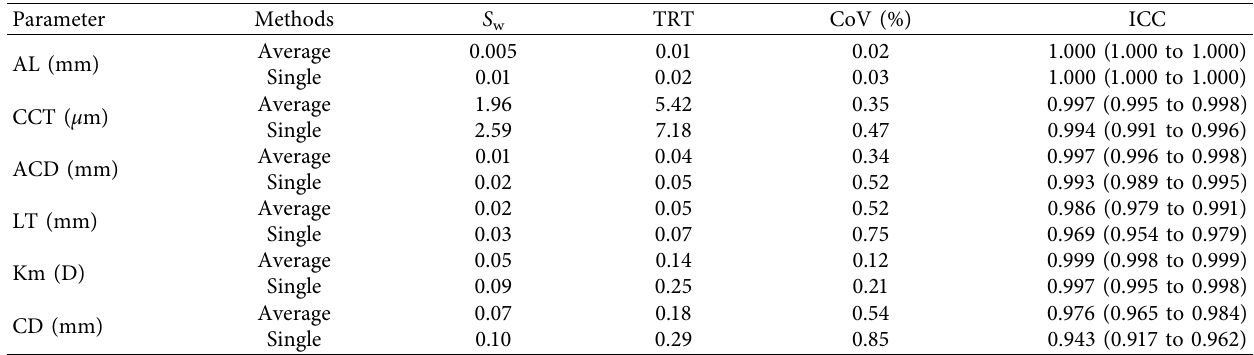
Table 4: Interobserver reproducibility outcomes for biometric measurements obtained using an IOLMaster 700 swept-source optical coherence tomography-based biometer in children.